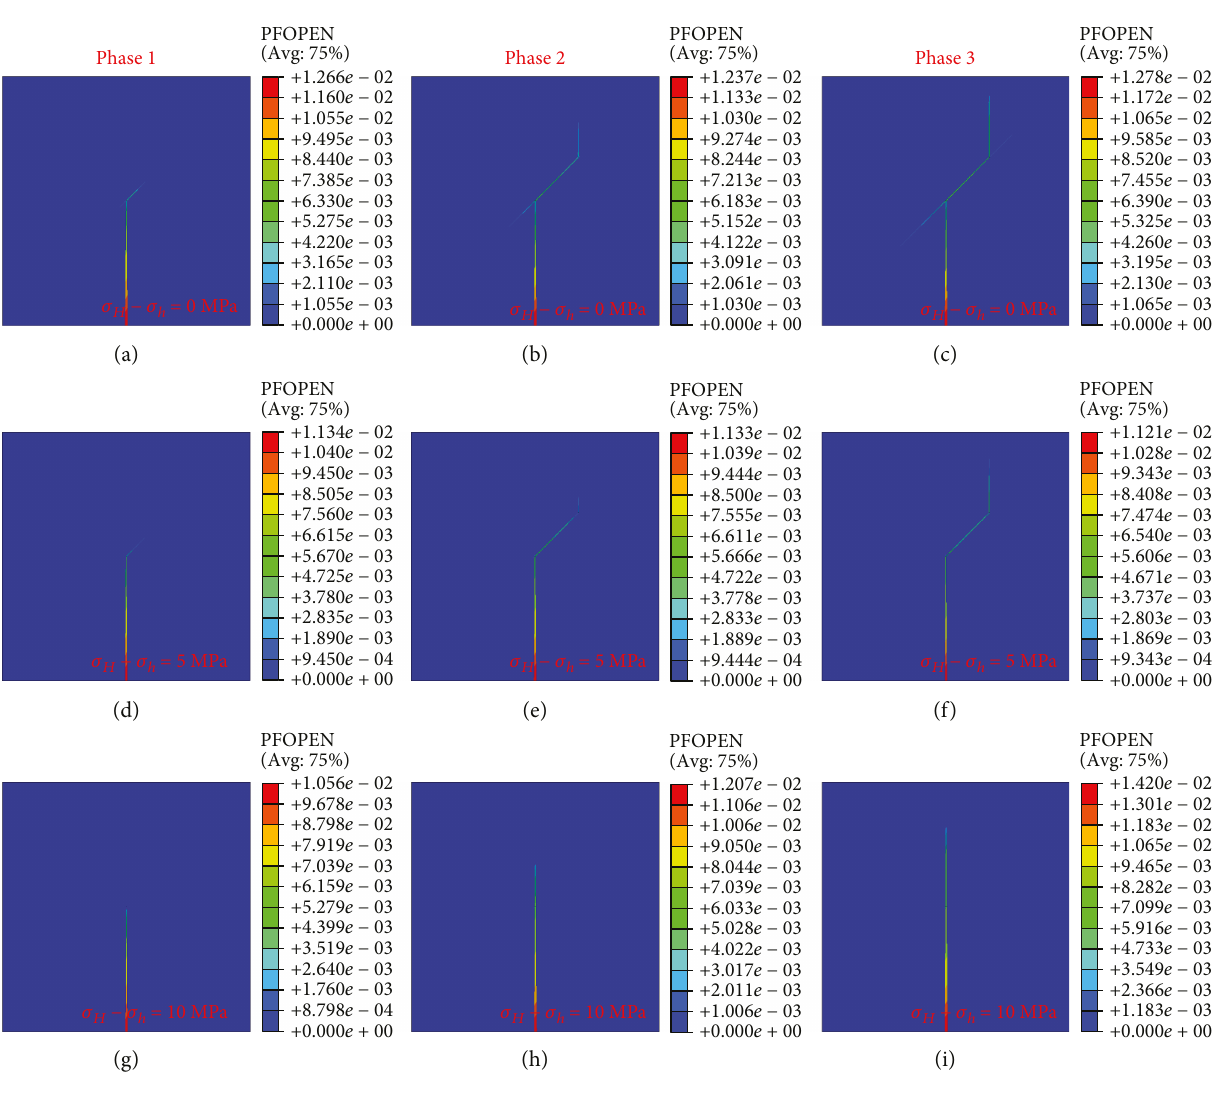
Figure 8: Approaching angle of 45 °